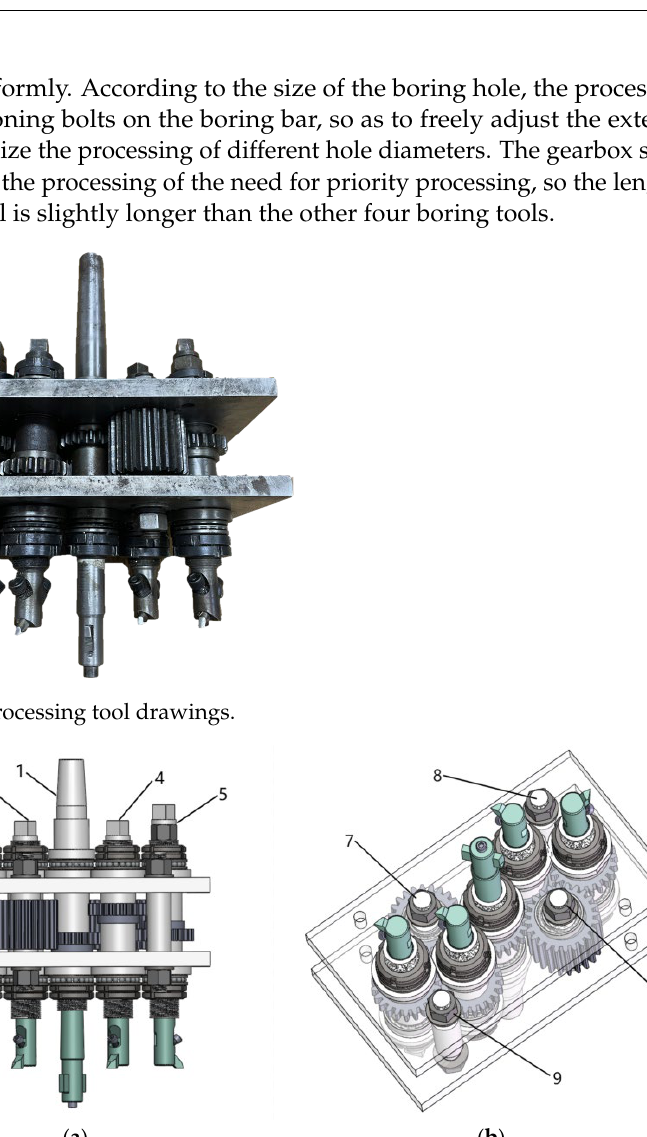
( b ) Figure 9. ( a ) Three dimensional diagram of the gearbox; ( b ) boring process processing. The follow- ing parts are shown: 1, processing tools; 2, positioning base; 3, special fixture, 4, tool support.